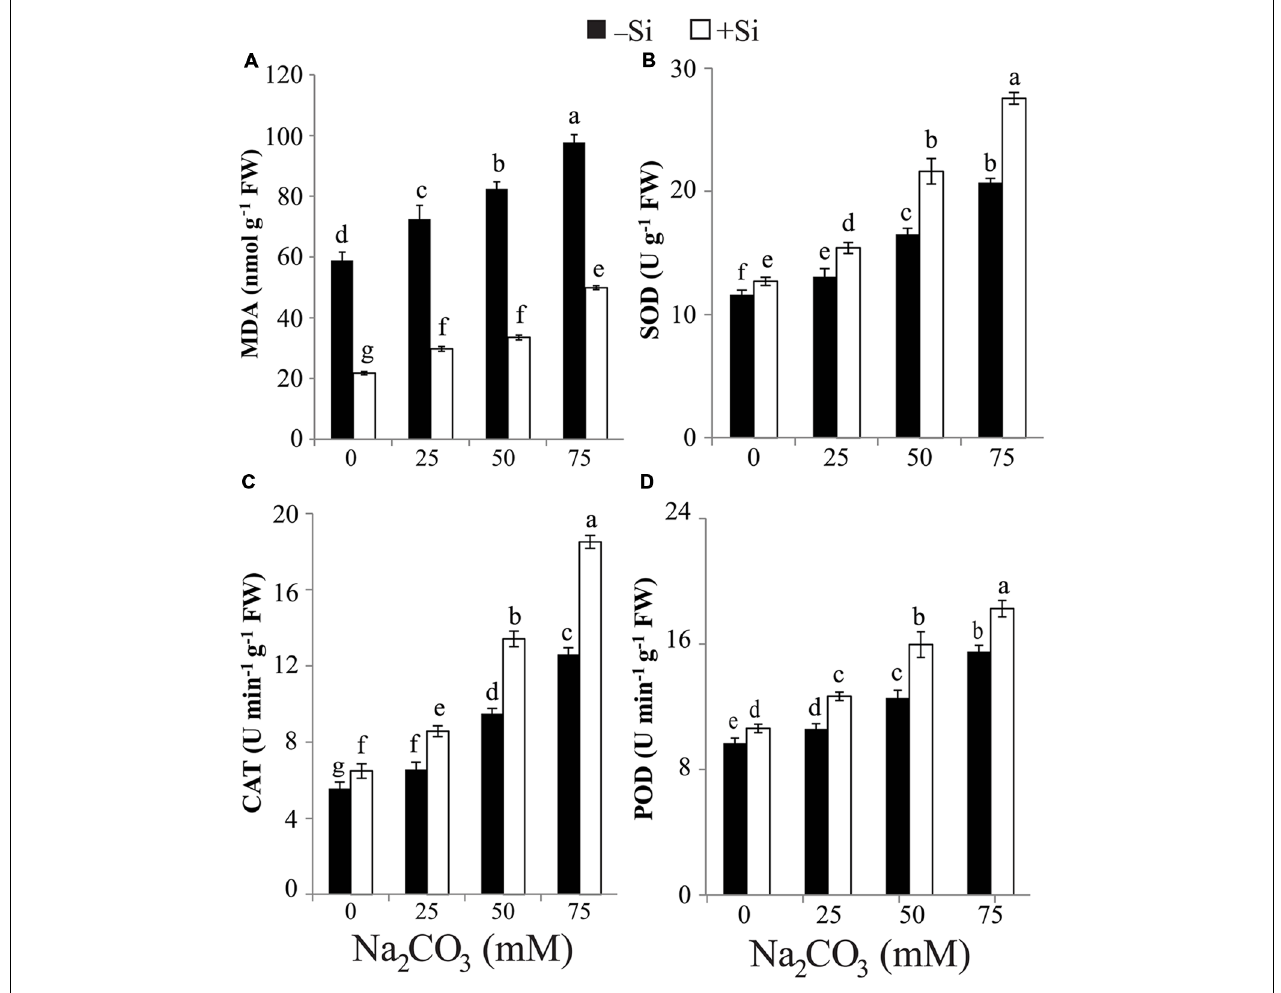
FIGURE 3 | Effects of different levels of alkaline stress with and without seed-priming with silicon (Si) on (A) the content of malondialdehyde (MDA) and the activities of (B) superoxide dismutase (SOD), (C) catalase (CAT) and (D) peroxidase (POD) in leaves of 25-day-old maize plants. Bars represent standard deviation (SD) of the means ( n = 3). Different letters indicate significant differences among the treatments at P < 0.05, according to Duncan’s multiple range test. FW, fresh